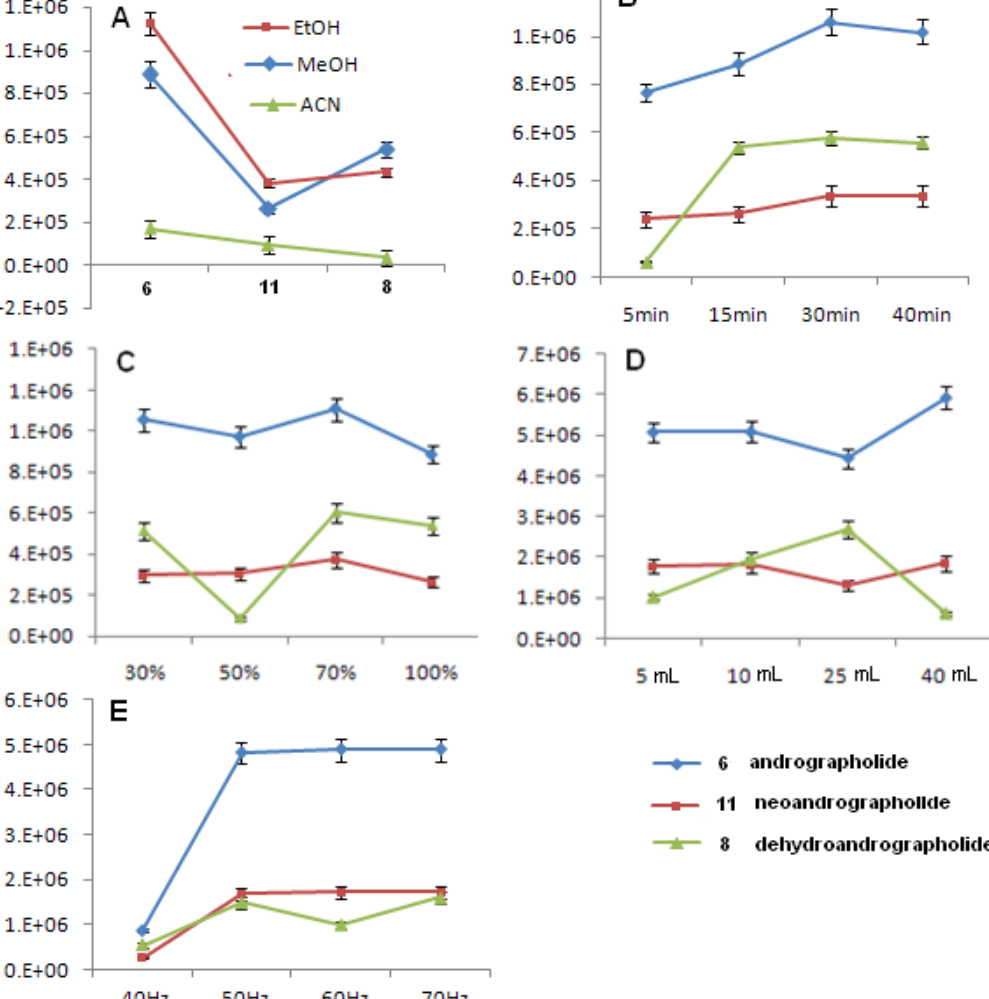
Figure 2. Effects of the types of extraction solvent ( A ), time ( B ), concentration of solvents ( C ), ratio of liquid to solid ( D ) and ultrasonic frequency ( E ) were investigated on yields of andrographolide ( 6 ), neoandrographolide ( 8 ) and dehydroandrographolide ( 11 ) in A. paniculata